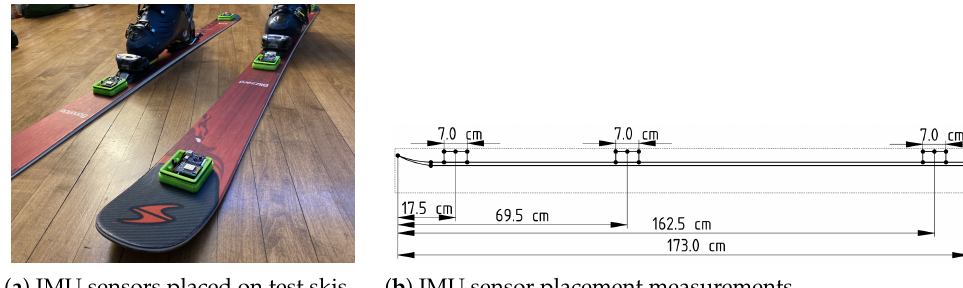
Figure 7. IMU sensor placement details.